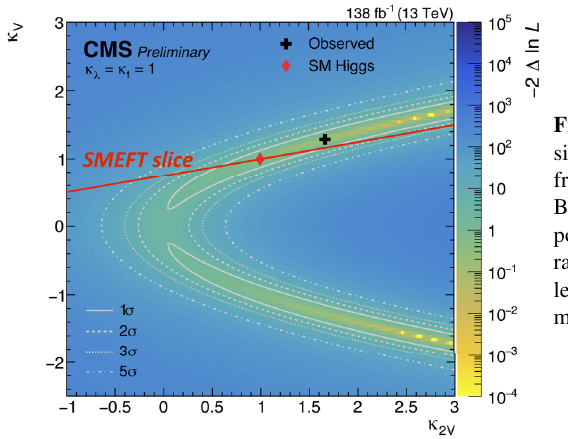
Figure 5. Experimental CMS exclu- sion plot in the a 1 , a 2 plane (reproduced from [22] under the Creative Commons BY 4.0 license.) We have superim- posed the SMEFT slice through this pa- rameter space, that is seen to run paral- lel to one of the branches of the experi- mental exclusion